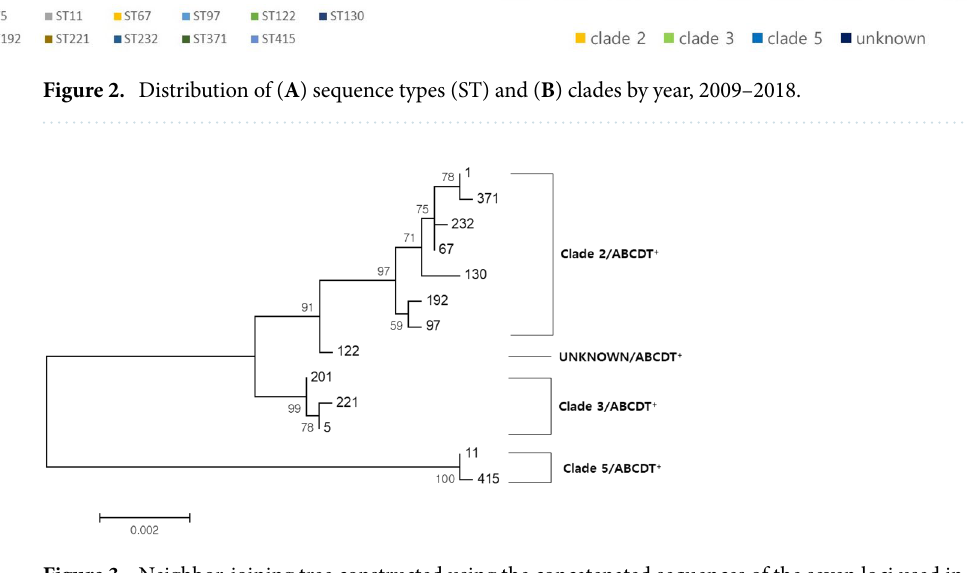
Figure 3. Neighbor-joining tree constructed using the concatenated sequences of the seven loci used in multi- locus sequence typing. Bootstraps were generated using 1000 replicates, and low values were removed for clarity. Sequence types (STs) are shown as numbers. The STs cluster into four groups, designated 2, 3, 5 and